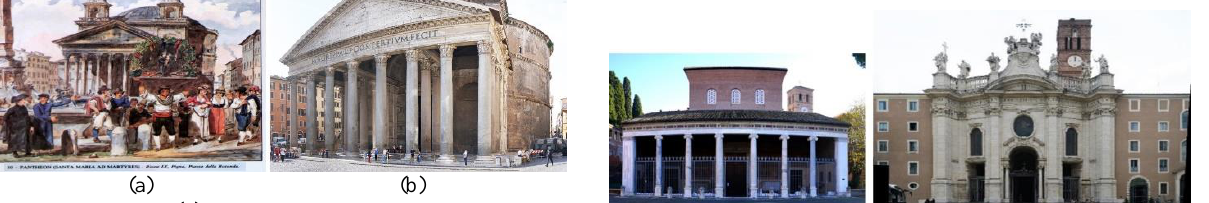
Figure 1. Pantheon. (a) Watercolour by Pinelli A., in the early 1800s. (b) Actual spherical panorama.